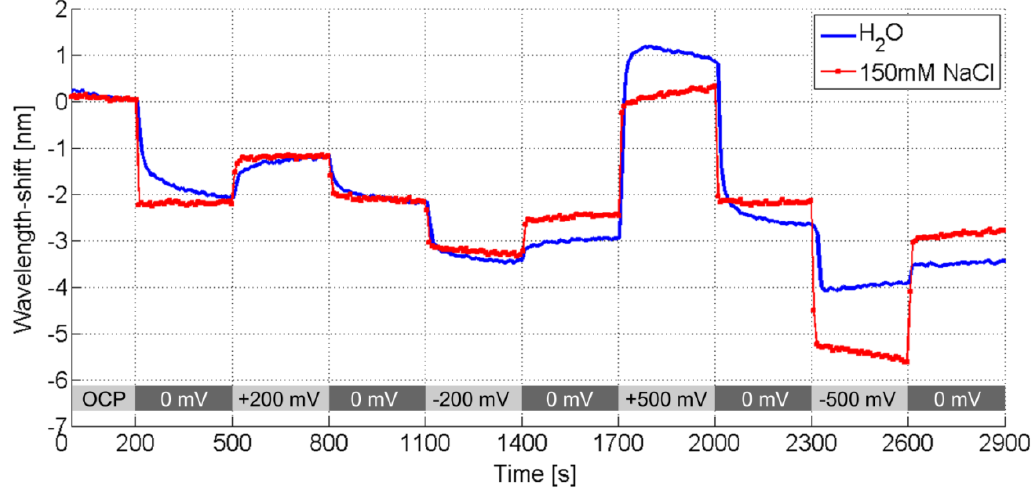
Figure 9. The voltage-dependent optical response of Au nanowires (width: 50 nm, height: 2 nm Cr + 15 nm Au) in an electrochemical flow cell in solutions of differing ionic strength. At the beginning of the measurement (<1,400 s) the optical response in 150 mM NaCl is almost step-like compare to the response in ultrapure water, where the response is slower because of the low concentrations of (naturally existing) ions e.g., O H − , C O 3− , or H + . At voltages of more than −200 mV in water the unprotected silver reference electrode began to coat the nanowire array with silver ions, thus altering the measurement baseline and optical